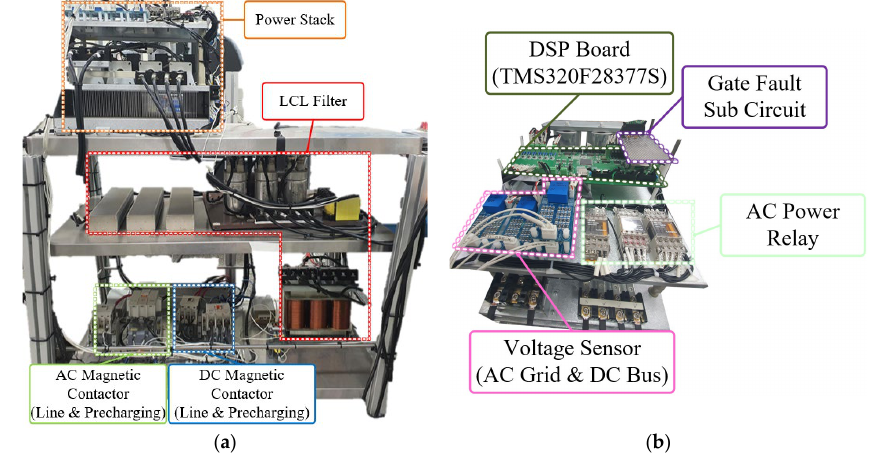
Figure 16. ( a ) ILC; ( b ) power stack of ILC.